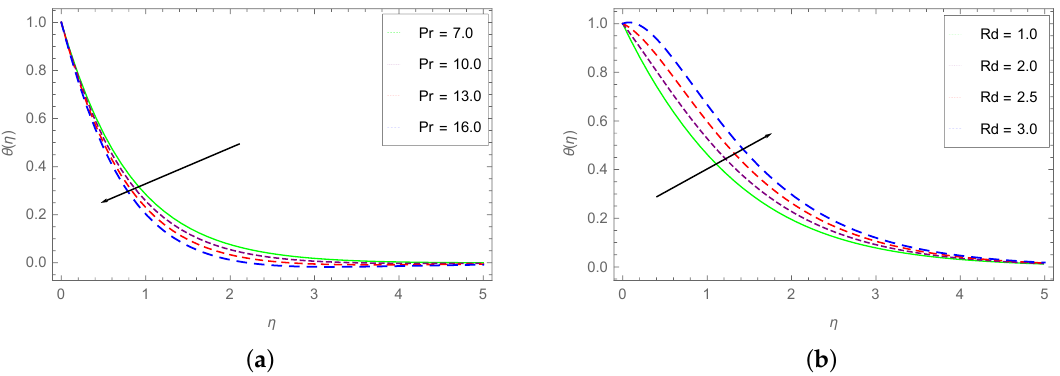
The variation of the fluid temperature θ ( η ) with increasing Pr (Prandtl number) and Rd (radiation parameter) is displayed in Figure 7a,b. The values of Pr are taken as 7.0, 10.0, 13.0, 16.0, while those of Rd are taken as 1.0, 2.0, 2.5, 3.0. Figure 7a shows that the Carreau fluid temperature drops with the rising η at fixed Pr . The rate of decrease of θ ( η ) is much faster at smaller η . As the Pr values are increased, the temperature field profiles drop. The spacing between θ ( η ) curves is more prominent at the intermediate values of η . The drop in the fluid temperature with the enhancing Prandtl number is due to the smaller thermal diffusivity of the Carreua fluid, which causes a reduction in the temperature of the fluid. Figure 7b depicts the dependence of the temperature field on Rd . It can be observed that the fluid temperature augments with the rising Rd values. The rate of enhancement in θ ( η ) with increasing Rd is more drastic for smaller η values. The θ ( η ) curves overlap beyond η = 4.0. The augmenting fluid temperature with the higher Rd is due to the stronger heat source.